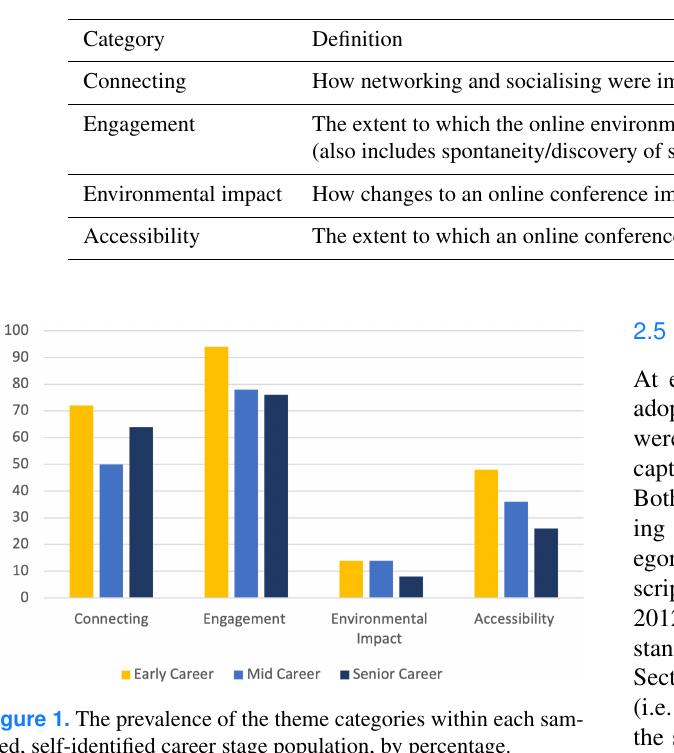
Table 4. The final categories that were used in the analysis of the responses to the survey.